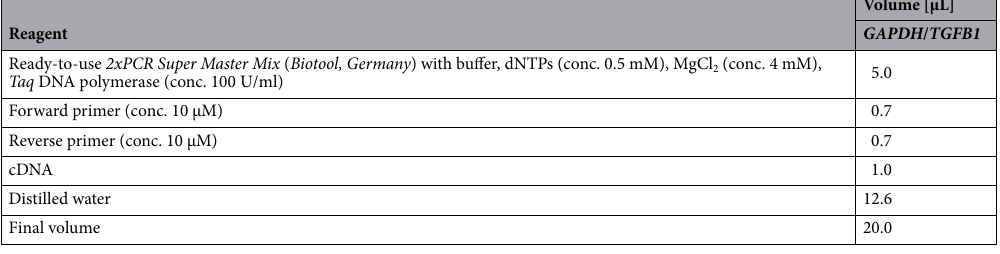
Table 1. Composition of mixtures for PCR reactions.